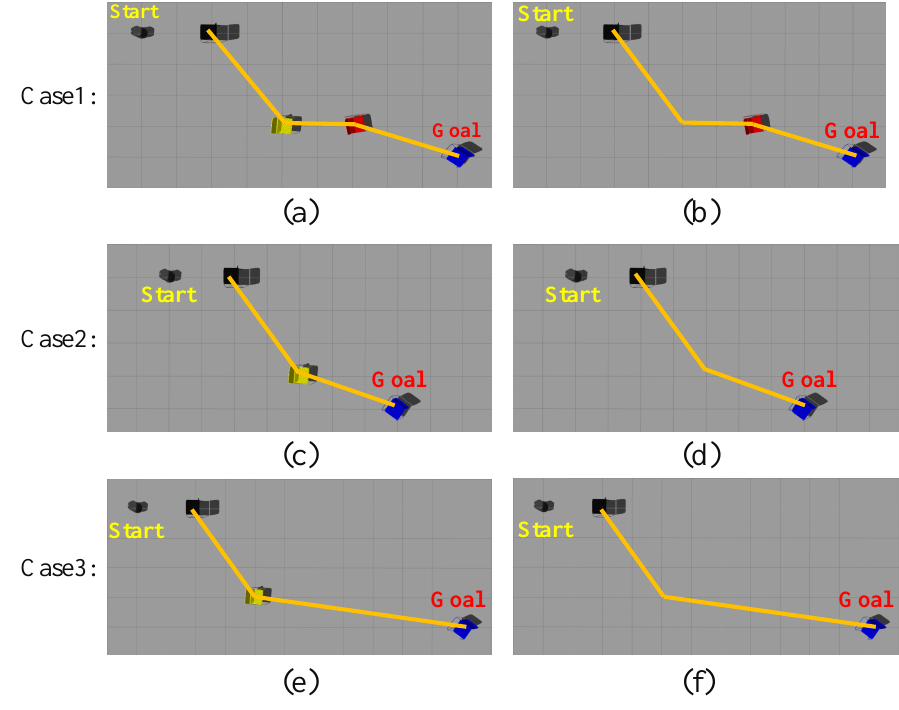
Figure 22. Navigation examples when objects in the environment models are moved. Yellow lines indicate the topological associations between objects. Case 1 shows that the robot can